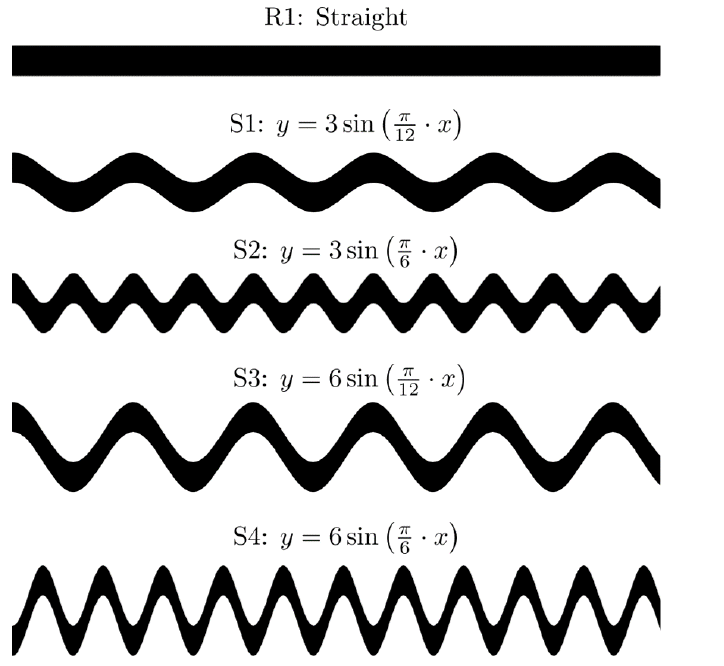
Figure 3. Spacer geometries R1, S1, S2, S3, and S4, and corresponding sinusoidal functions. Images of fouling patterns for different spacer morphologies need to be processed to map color intensity into surface concentration for comparison with numerical